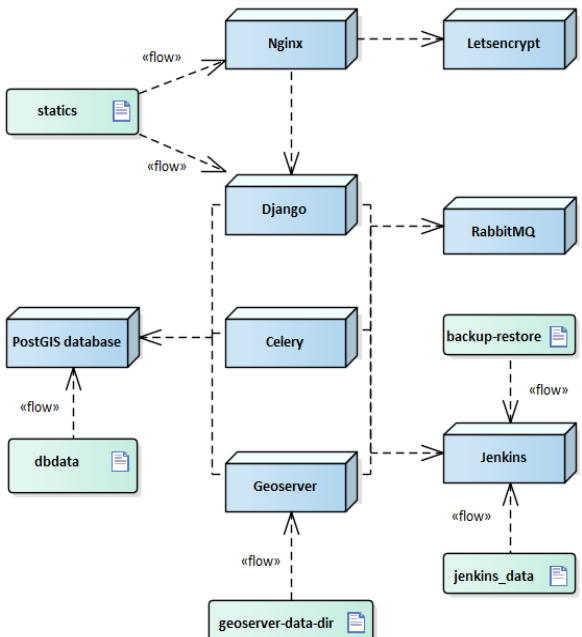
Figure 6 . GeoNode Docker setting for